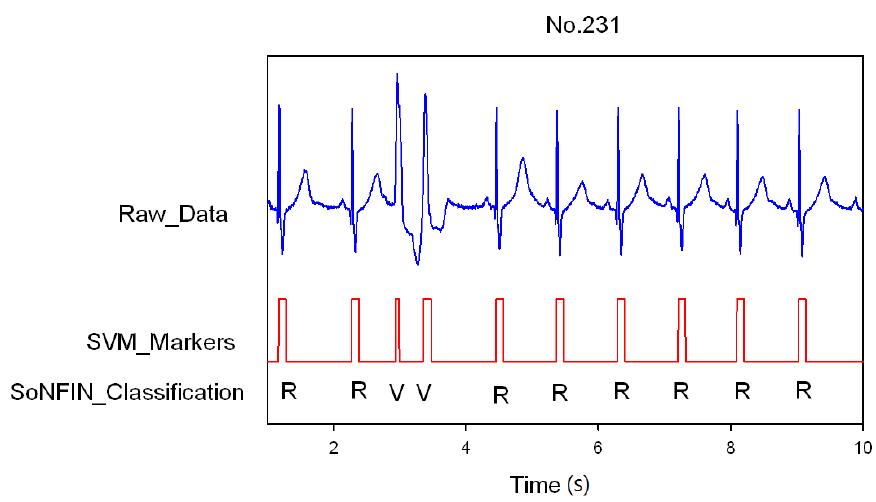
Figure 6. SVM marks the heartbeats of ECG, and then SoNFIN classifies continuous two PVC beats happening in the RBBB beats for file No.